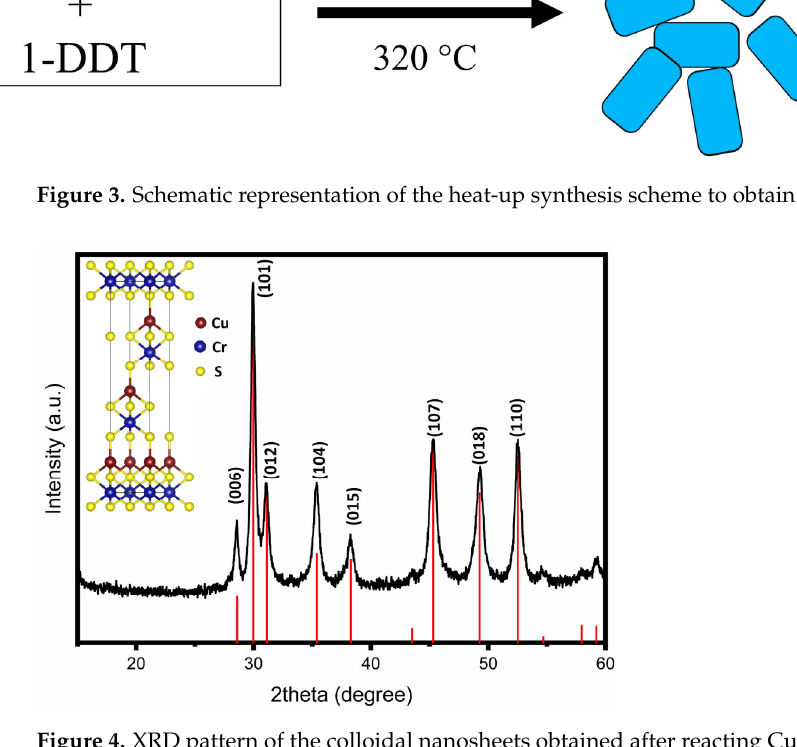
Figure 4. XRD pattern of the colloidal nanosheets obtained after reacting Cu(DDTC) 2 and CrCl 3 at 320 °C for 60 min in the presence of 1-DDT and OLA. The vertical red lines represent the standard diffraction data standard (ICDD# 01-079-7417) for CuCrS 2 . The unit cell structure of CuCrS 2 is shown in the inset.